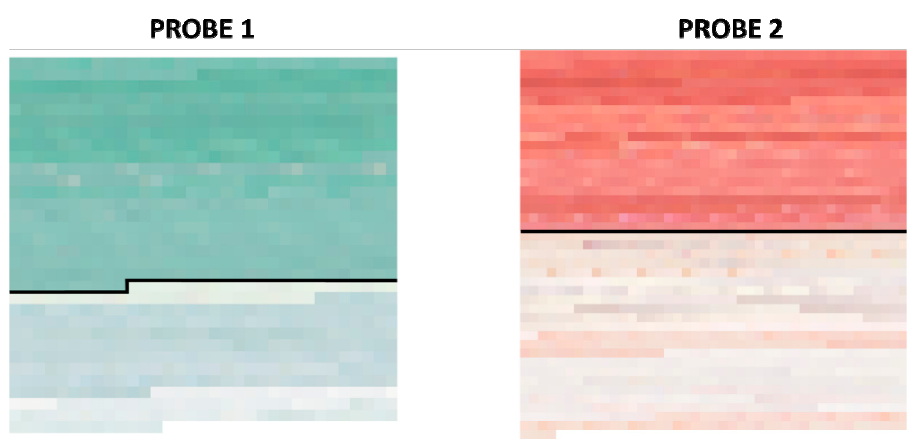
Figure 8. sRGB renderization of the manually retrieved ground truth set of pigments (above black line) and the white (below black line) pixels from both probes.